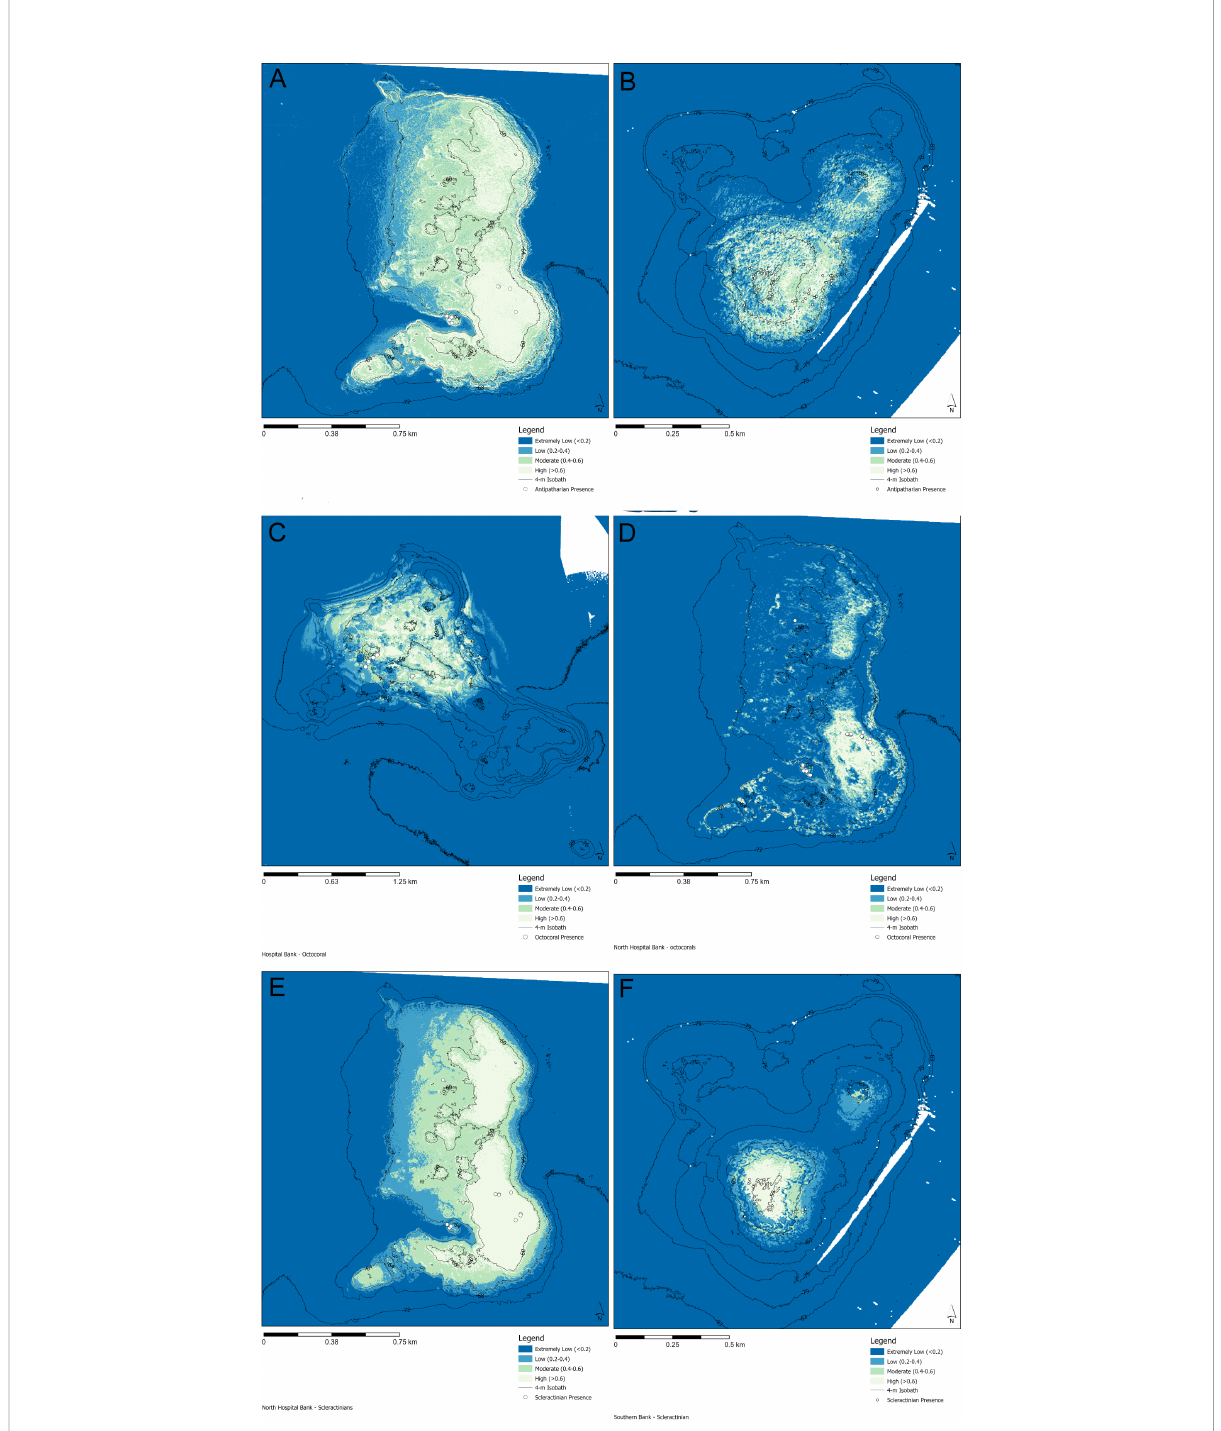
FIGURE 5 Predictive model of habitat suitability for antipatharians, octocorals or scleractinians on the South Texas Banks. Models for antipatharians were run for (A) North Hospital Bank and (B) Southern Bank. Models for octocorals were run for (C) North Hospital Bank and (D) Hospital Bank. Models for scleractinians were run for (E) North Hospital Bank and (F) Southern Bank. Areas that are white to pale blue have a higher probability of the presence of antipatharians or octocorals, areas that are darker blue have a low probability that of antipatharians or octocorals will be